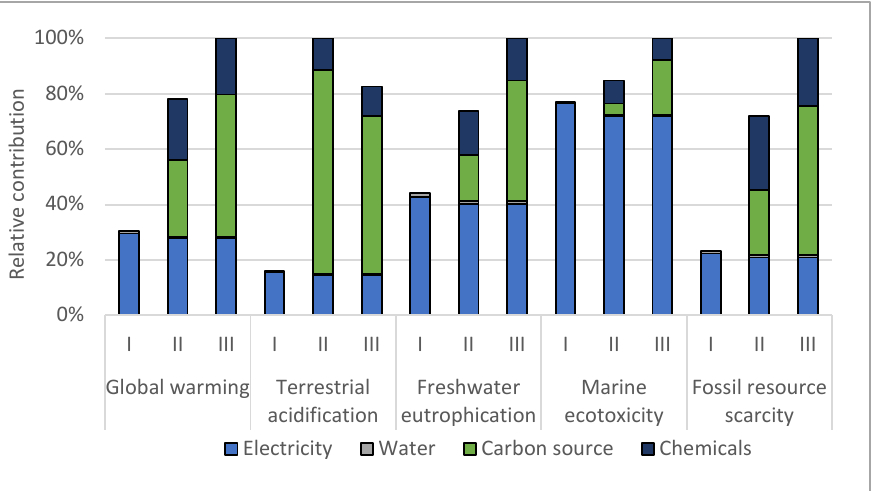
Figure 4. Selected LCIA results for the different inoculation production processes. Sc. I uses breadcrumbs as the carbon source. Sc. II uses molasses. Sc. III is based on glucose.